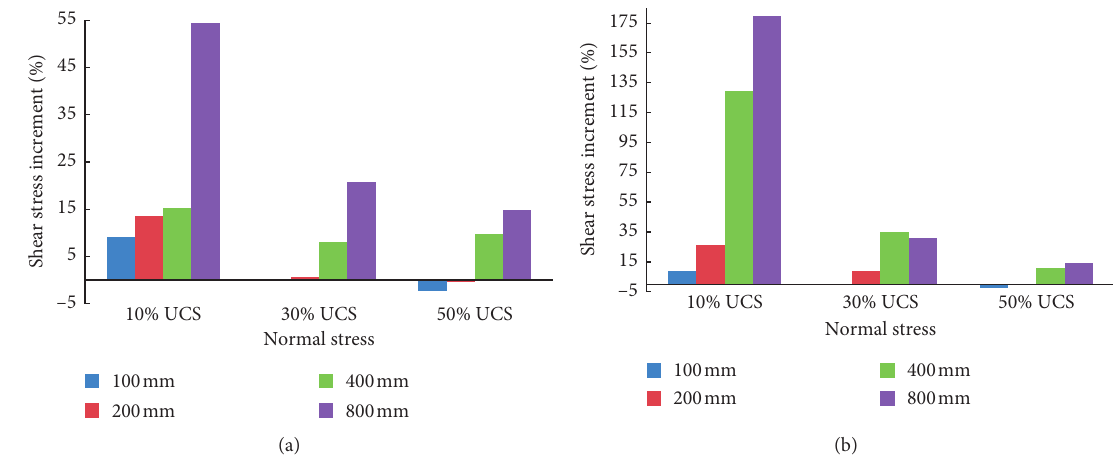
Figure 12: Shear stress increment under CND condition compared to CNL condition. (a) Repeated rock joints. (b) Enlarged rock